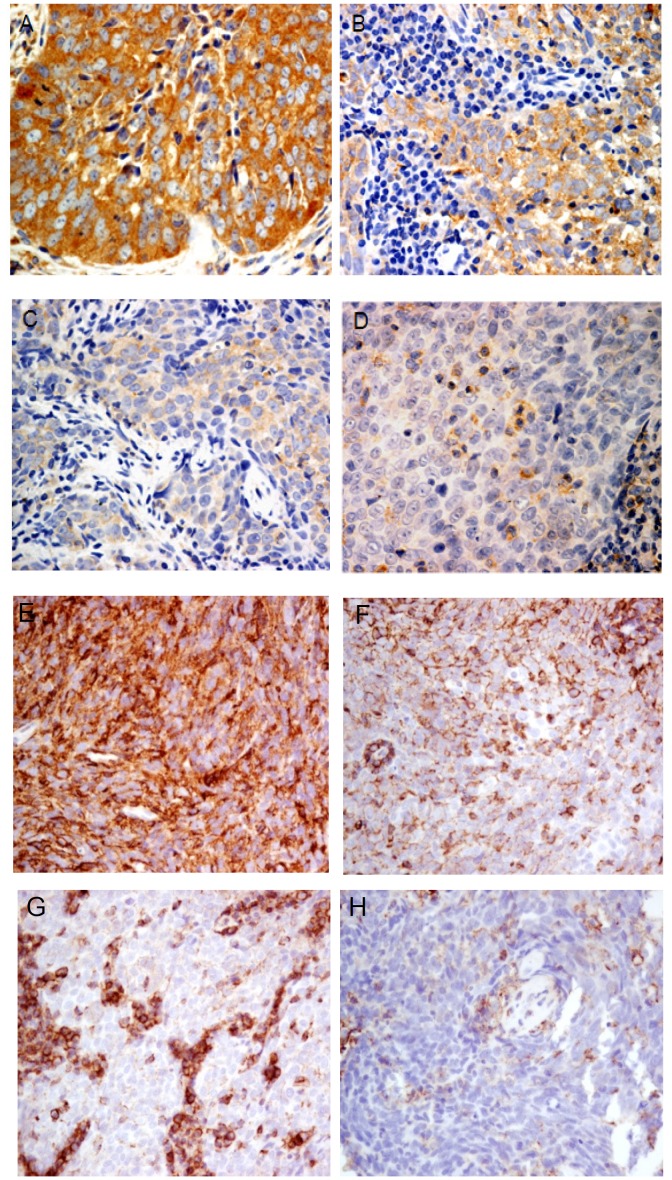
Immunohistochemical analysis of CCR7 and CD44 expression in primary NPC.Representative primary NPC cases with high (A), medium (B), low (C) expression of CCR7. (D) Primary NPC with absence of CCR7 expression was shown. CCR7 staining were detected in few infiltrating lymphocytes, but not in the tumor cells. Primary tumors with high (E) and medium (F) CD44 expression were shown. In (G) and (H), weak CD44 expression was detected in the tumor cells while strong CD44 staining in infiltrating lymphocytes was commonly found.